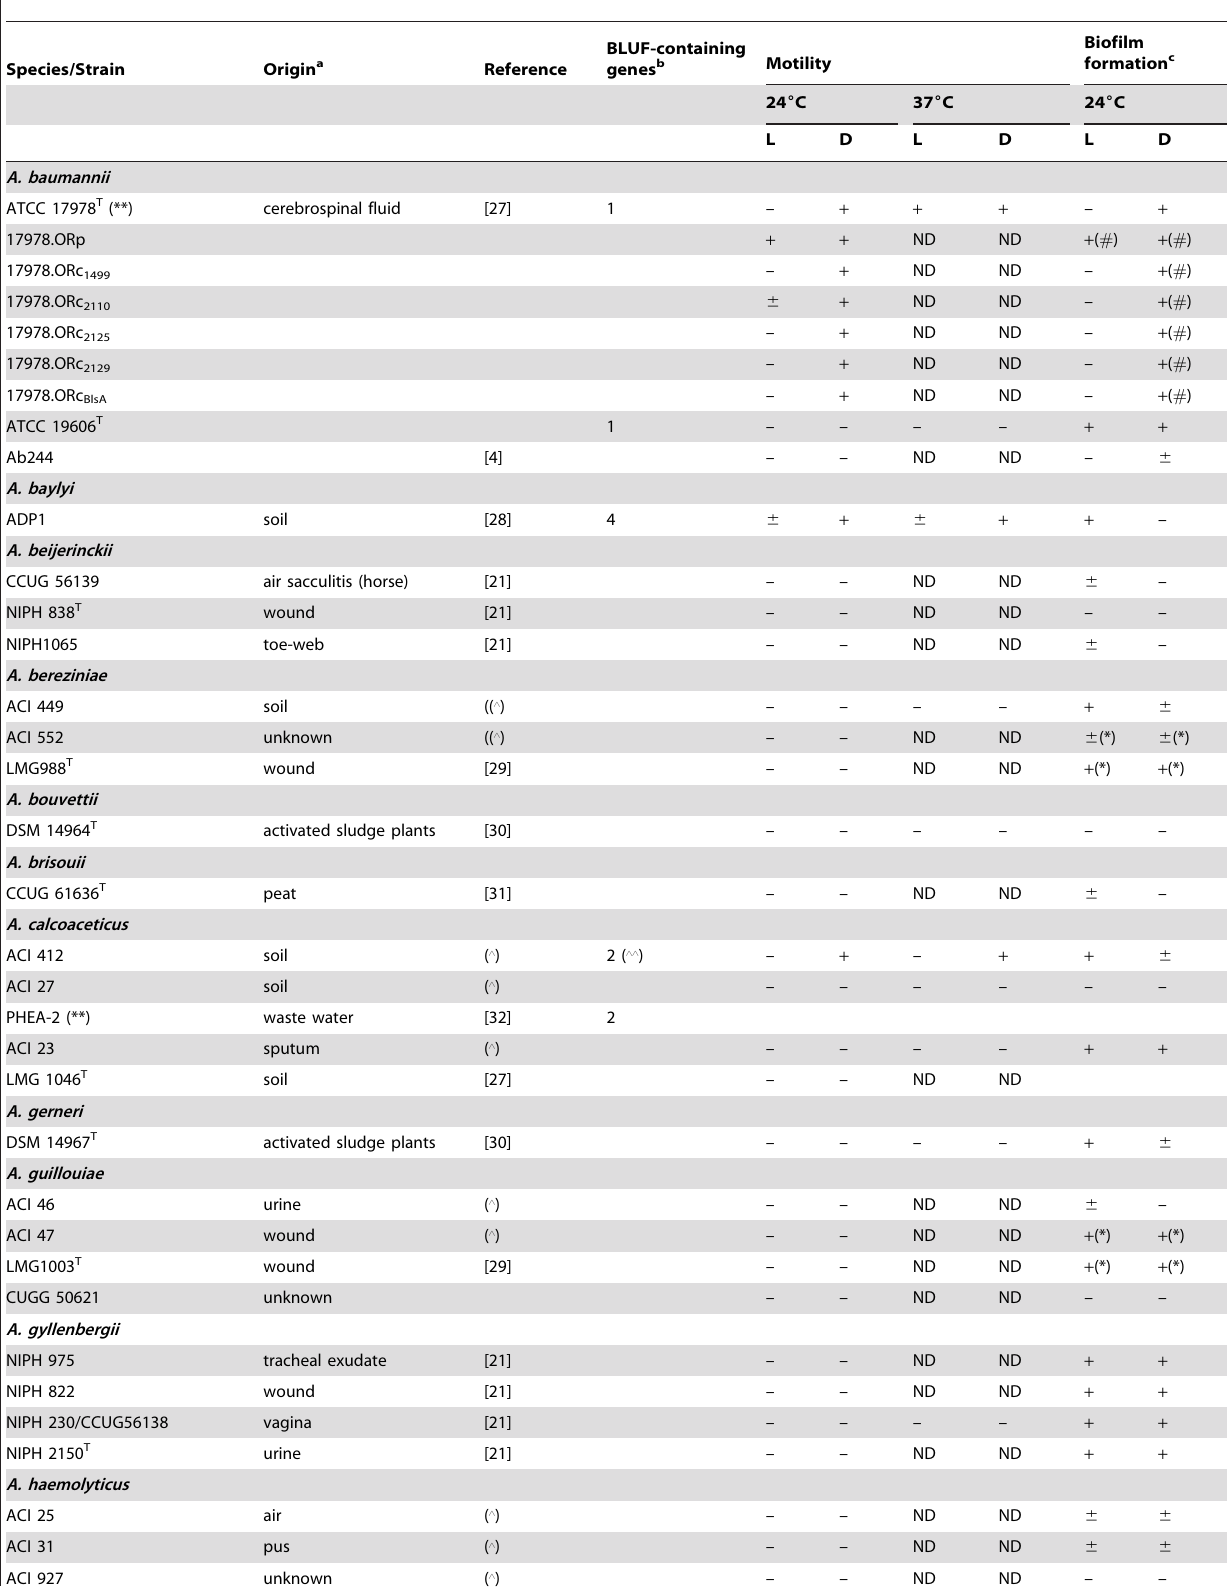
Table 2. Blue light and temperature (24 u C vs. 37 u C) regulation of motility and biofilm formation by Acinetobacter strains studied in this